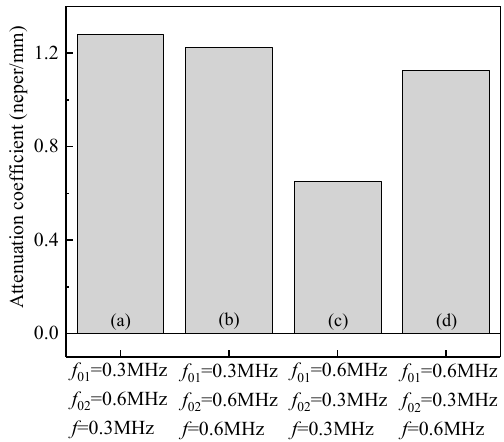
Figure 13. Kinetic energy (mJ): ( a ) f 01 = 0.3 MHz, f 02 = 0.6 MHz, f = 0.3 MHz; ( b ) f 01 = 0.3 MHz, f 02 = 0.6 MHz, f = 0.6 MHz; ( c ) f 01 = 0.6 MHz, f 02 = 0.3 MHz, f = 0.3 MHz; ( d ) f 01 = 0.6 MHz, f 02 = 0.3 MHz, f = 0.6 MHz.